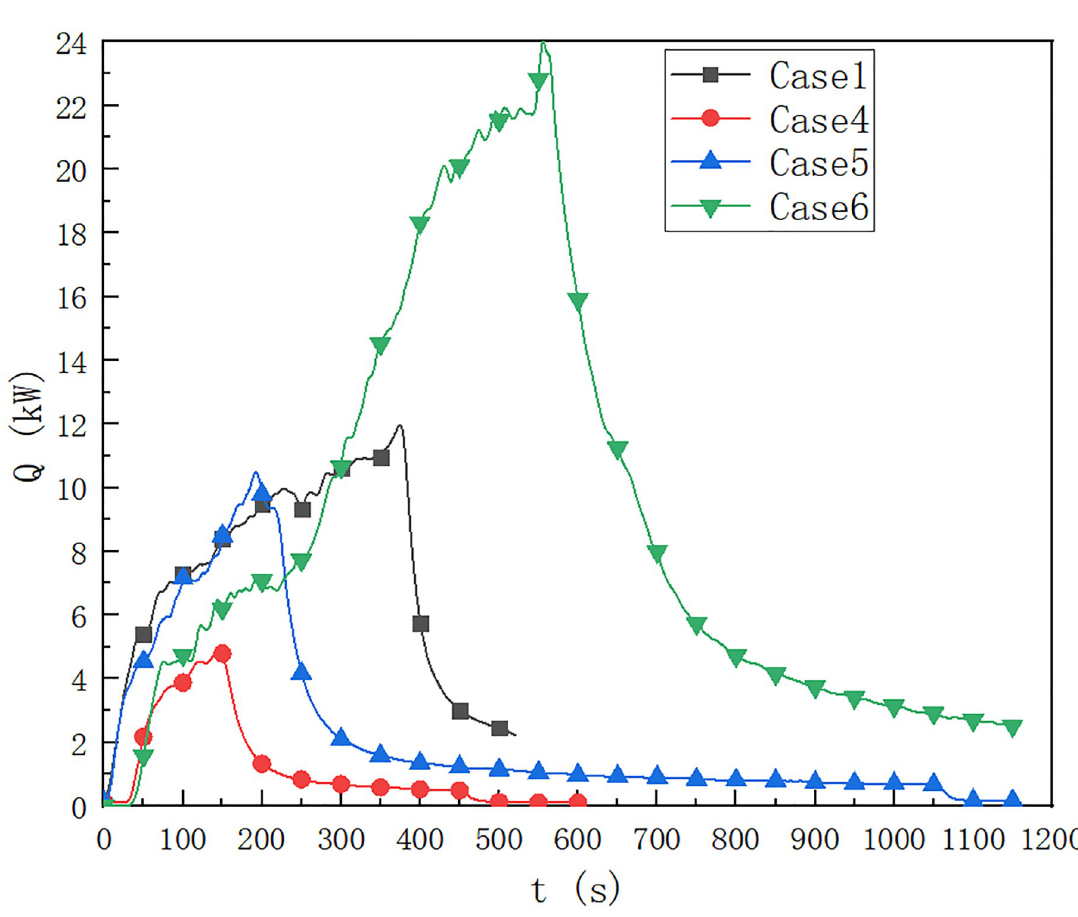
Fig 7. Prediction of fire HRR at 0.5 m from fire source in cable compartment of utility tunnel in cases of 1,4,5 and 6.